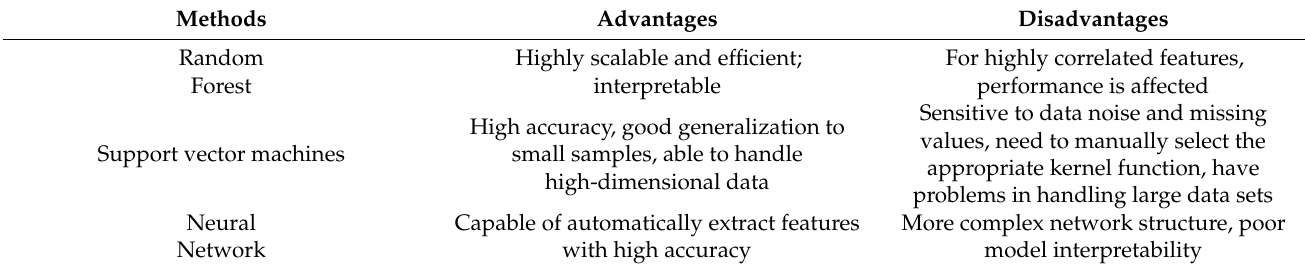
Table 3. Comparison of the advantages and disadvantages of machine learning algorithms to identify